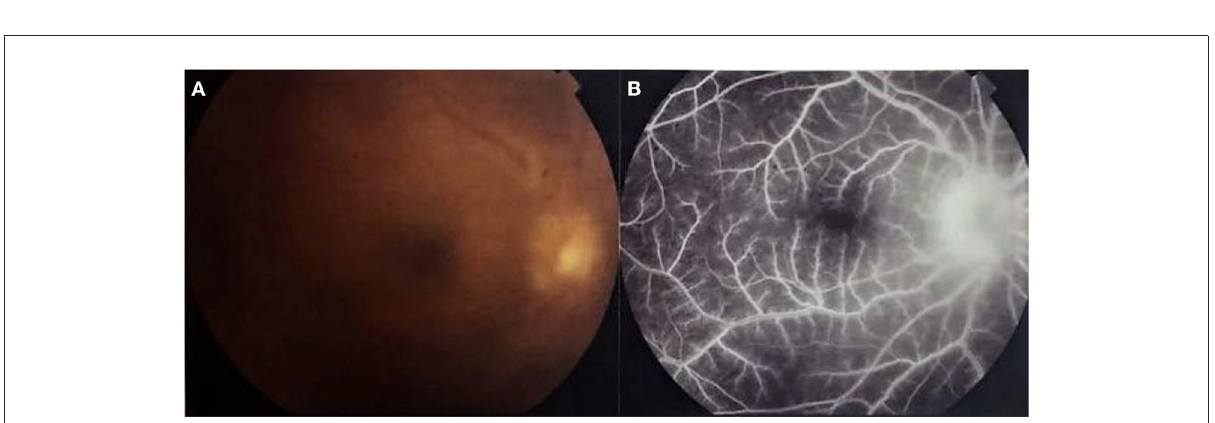
FIGURE4 Color photo and fundus fluorescein angiography (FFA) of a patient with active Behçet uveitis. (A) Color photo showing disc edema, sheathed vessels, blunt macular reflex. (B) FFA showing active vasculitis (fern-like configuration typically extending beyond one quadrant) and disc leakage (Images courtesy of Dr. Wassef A,